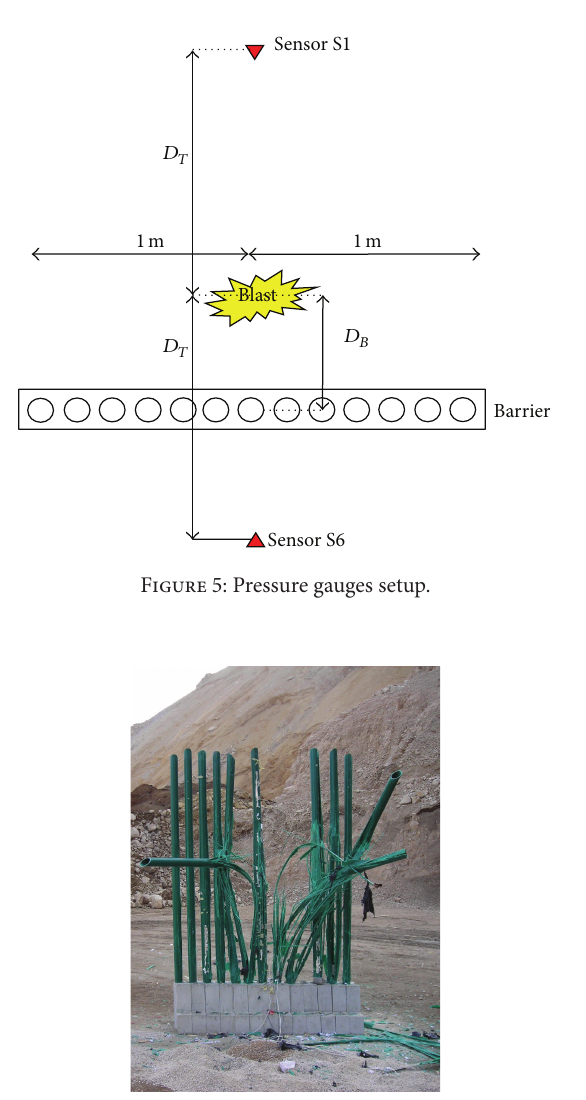
Figure 6: Barrier specimen after the third test.